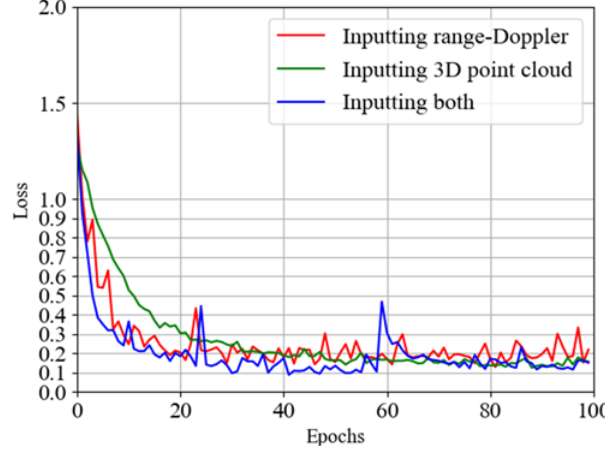
Figure 17. Loss curves of three different networks. Table 4. Accuracy and Loss of The Three Networks Using Different Kinds of Input.